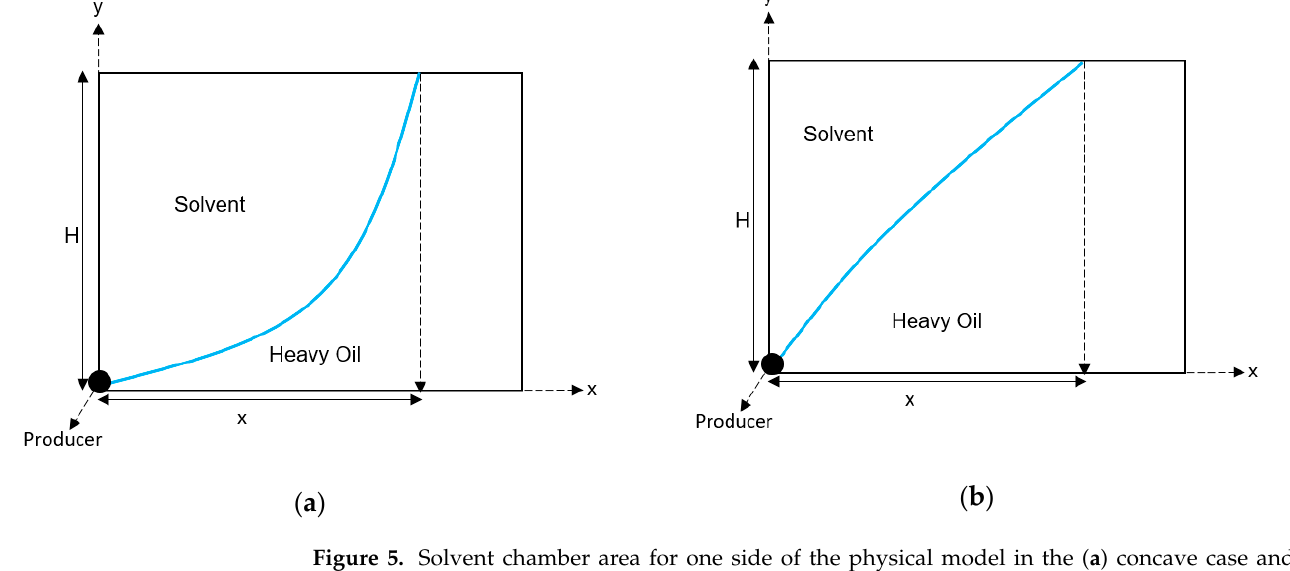
Figure 5. Solvent chamber area for one side of the physical model in the ( a ) concave case and ( b ) convex case.